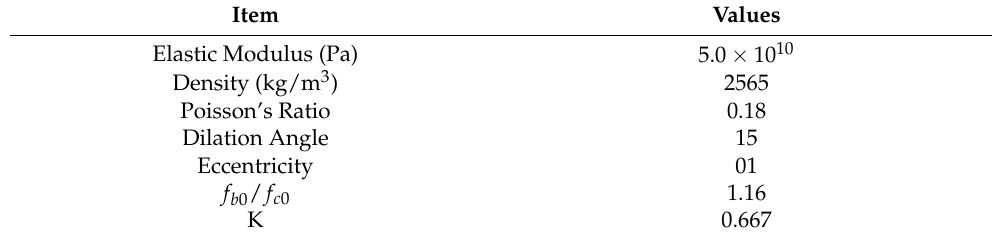
Table 2. Material properties for UHPC (CDP model).